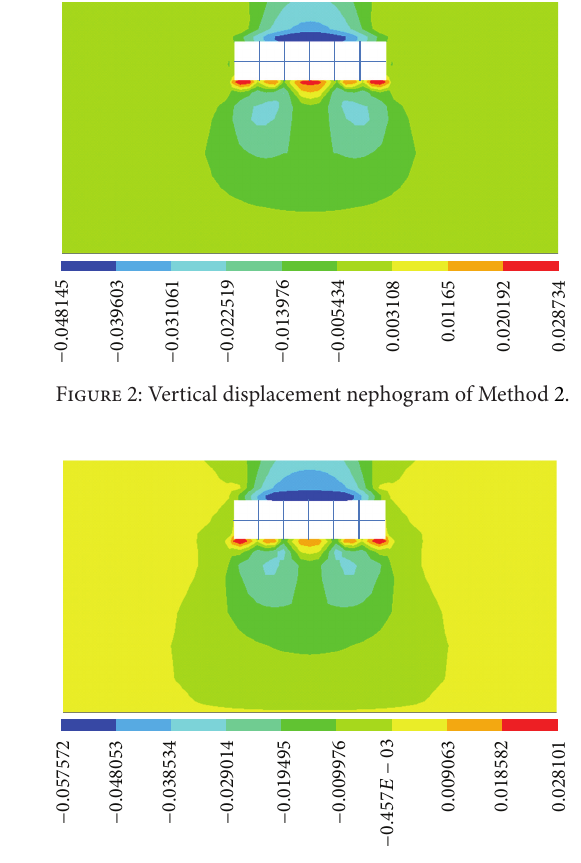
Figure 3: Vertical displacement nephogram of Method